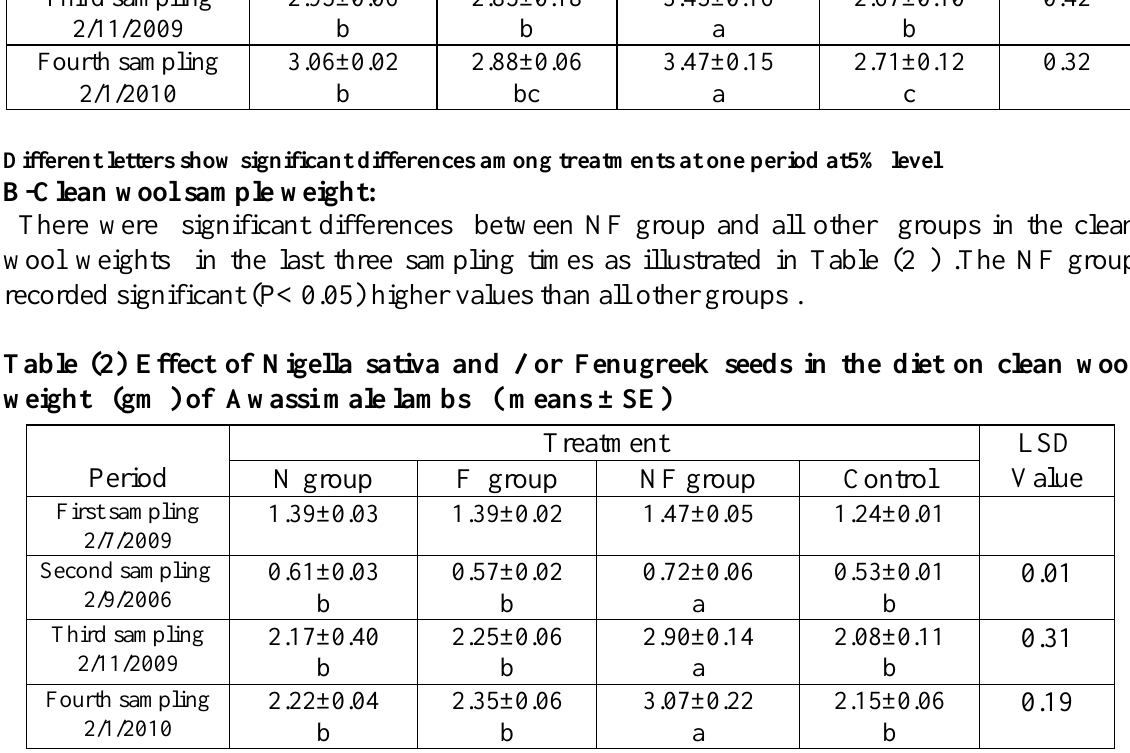
Different letters show significant differences among treatments at one period at5%